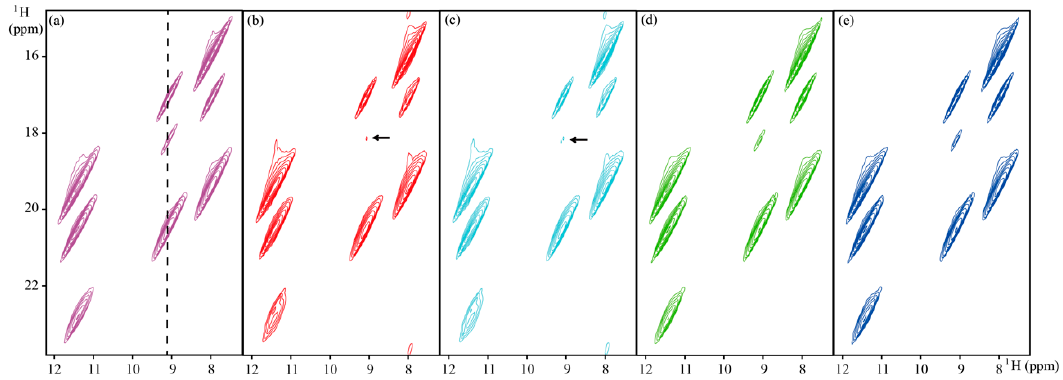
Figure 4. Reconstructed 2D 1 H– 15 N best-TROSY spectra of ubiquitin with 20% NUS data. ( a ) The fully sampled spectrum; ( b – e ) reconstructed spectra using the LRHM, LRHMF, SLS, and SLSMF, respectively. Note: The contours of spectra are at the same level.